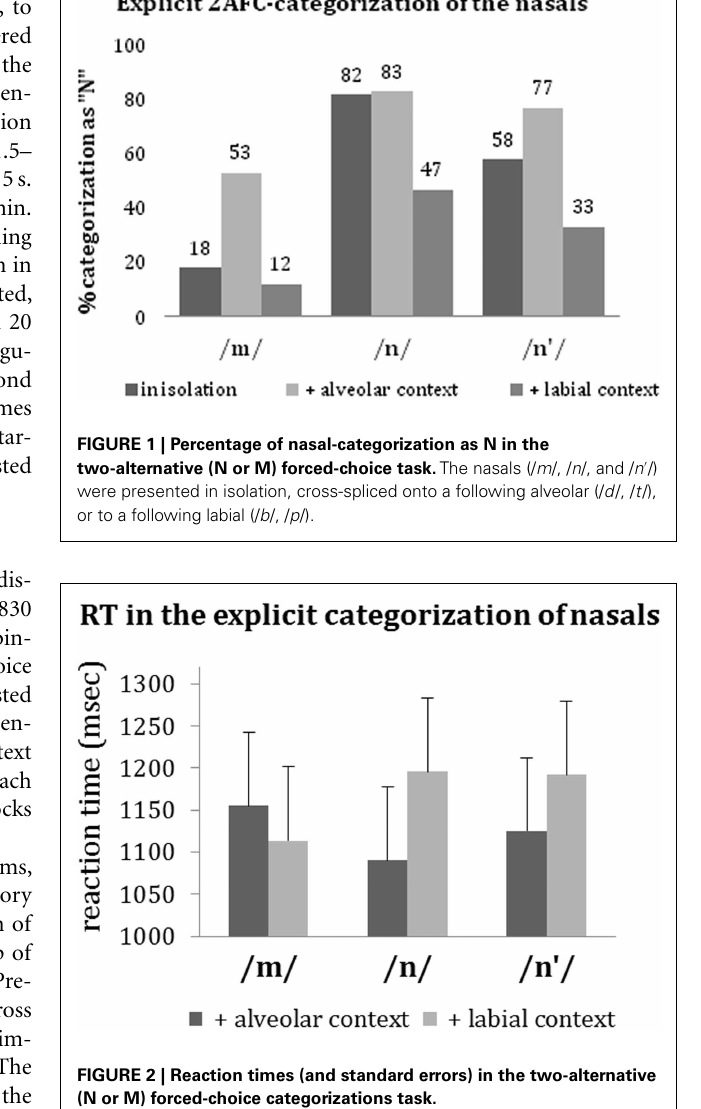
CATEGORIZATIONS Single